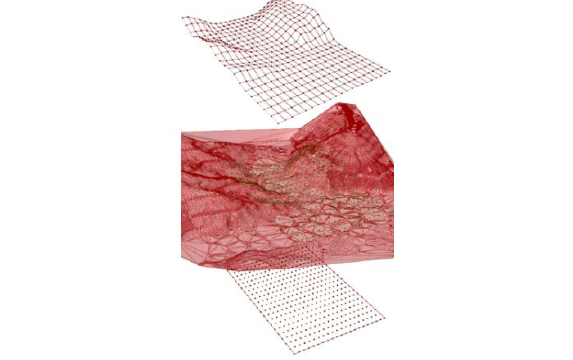
Figure 3. Scheme to transform in structured